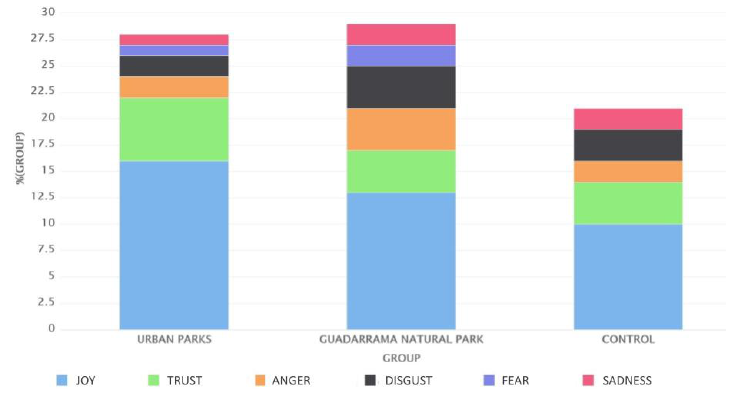
Figure 6. Comparison of emotions among the three main datasets.